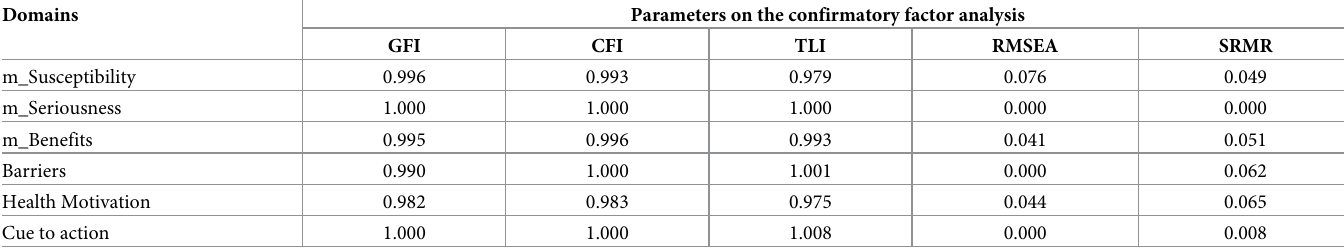
Table 5. Confirmatory factor analysis of the modified version of the Health Belief Model Applied to Influenza (mHBMAI) among people with chronic diseases in Serbian language. Domains